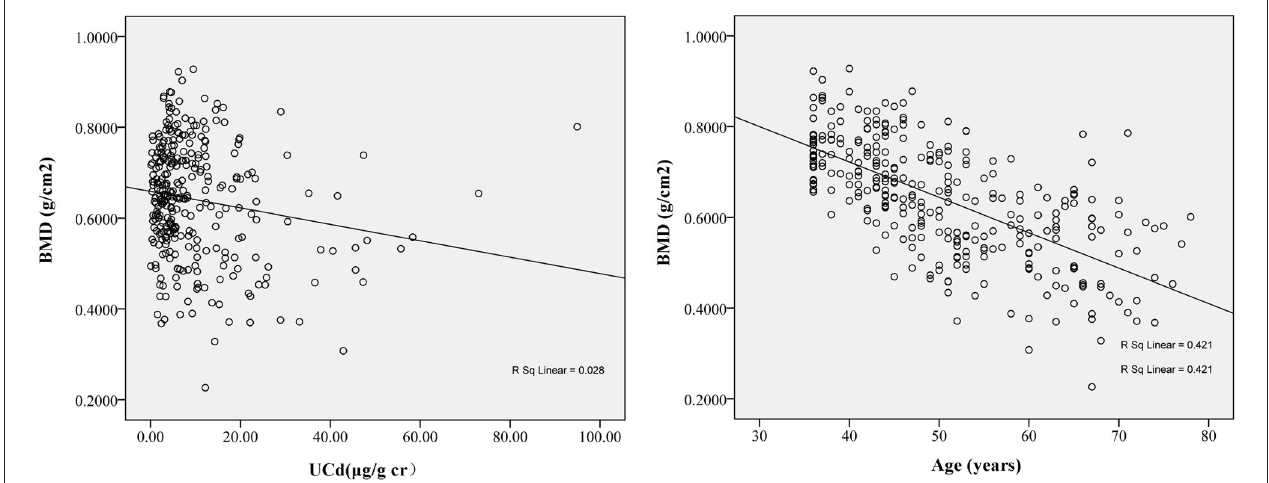
FIGURE 2 | The correlation between follow-up bone mineral density (BMD) and baseline urinary cadmium (UCd) ( r = − 0.12, p = 0.04) and baseline age ( r = − 0.67, p < 0.01). The BMD at follow-up decreased with increase of baseline UCd and age. The regression equation was BMD follow − up = − 0.003 × UCd baseline + 0.745 for UCd and was BMD follow − up = − 0.005 × Age baseline + 0.992 for age.